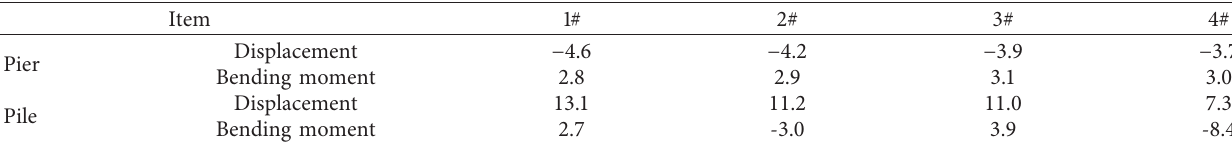
Figure 8: Displacement envelopes of pile No. 1 in Cases 3 and 4. Table 5: Response difference rates for Case 3 and Case 4